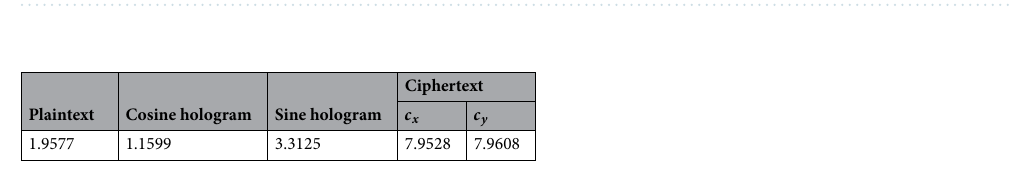
Table 2. The information entropy.